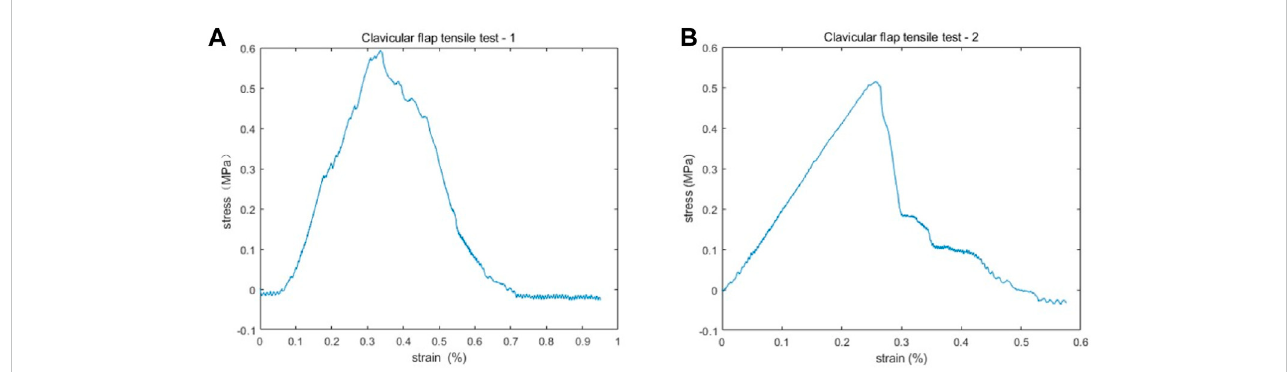
FIGURE 1 Thestress-strainresultsoftwoclavicularperiosteumsamplesafteruniaxialtensiletesting. (A,B) Thestress-straincurvesarehighlyconsistent.Intheinitial phase of stretching, the stain increases with stress linearly. The elastic modulus of the two periostea was 2.68 MPa (A) and 2.53 MPa (B) , respectively.